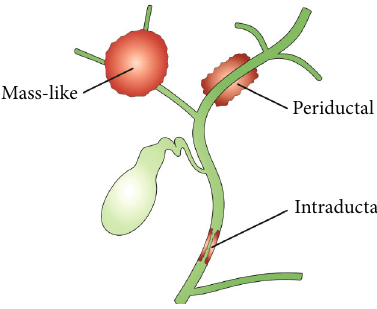
Figure 3: Classi fi cation of cholangiocarcinoma carcinoma according to the macroscopic